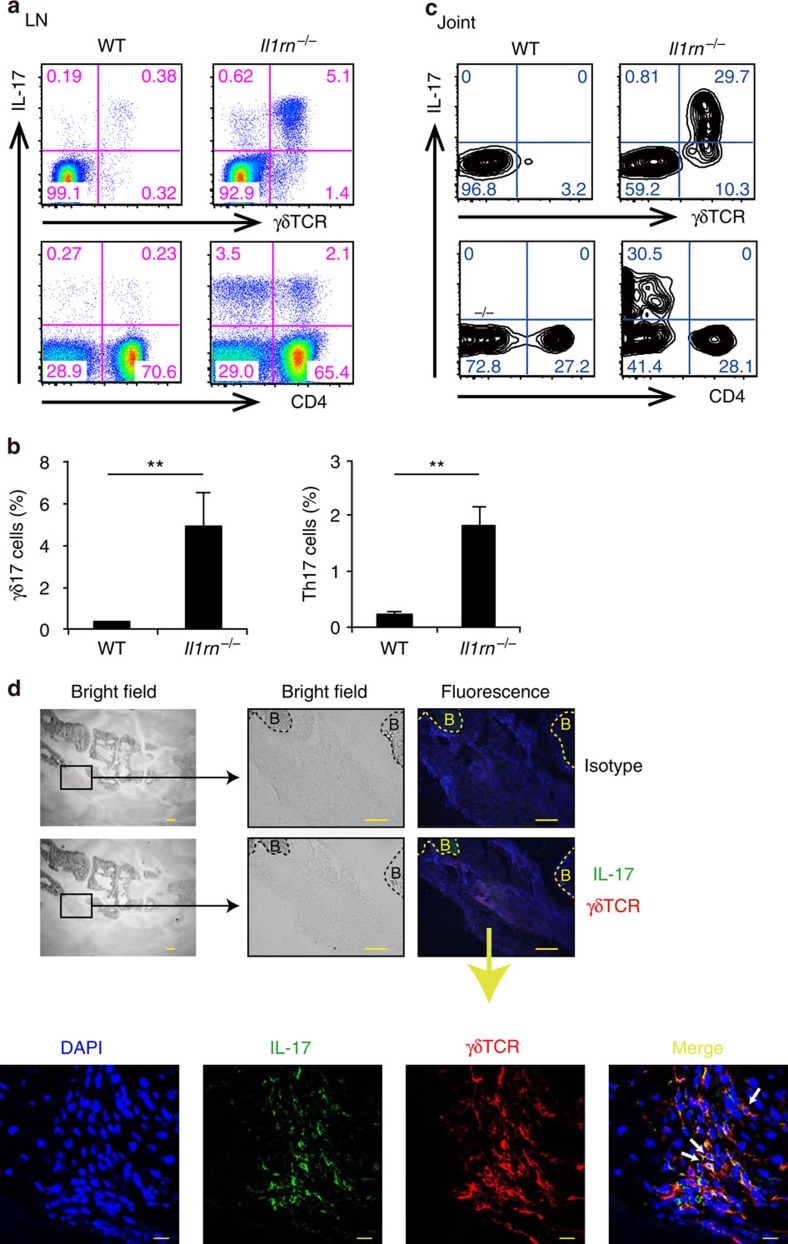
γδ T cells are the main source of IL-17 in the inflamed joints of Il1rn−/− mice.(a–c) Flow cytometry of LN cells from WT (n=3) and arthritic Il1rn−/− mice (n=3) (a) or joint-infiltrating cells from WT (pool of five mice) and arthritic Il1rn−/− mice (pool of two mice) (c). All cells were stimulated with P/I for 5 h, and then stained for intracellular IL-17. Numbers refer to percent cells in CD3ɛ+ cells. Quantification of IL-17+ γδ TCR+ and IL-17+ CD4+ in CD3ɛ+ cells are shown (b). **P<0.01 versus WT mice (unpaired Student's t-test). Data show mean±s.e.m. (d) Frozen sections of arthritic joints of Il1rn−/− mice were co-stained with anti-IL-17 Ab (green), anti-γδ TCR Ab (red) and 4,6-diamidino-2-phenylindole (DAPI) (blue). Sections were observed under a fluorescence microscope (top and middle panels, scale bars, 100 μm), and a confocal microscope (bottom panels, scale bars, 10 μm). B, bone. IL-17+ γδ TCR+ cells are shown by white arrows. Similar results were obtained in six other Il1rn−/− mice. All data except d are representative of >5 independent experiments.